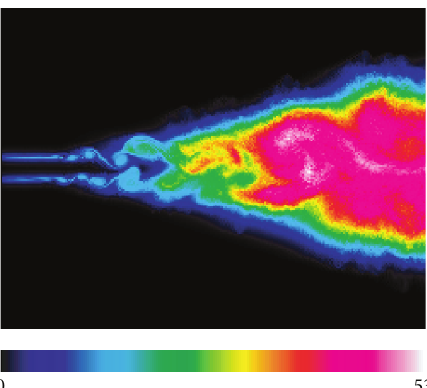
Figure 7: Instantaneous contours of the 𝑧 -direction averaged particle growth-rate, ⟨Ω nm ⟩ 𝑧 at 𝑡 ⋆ = 100 .